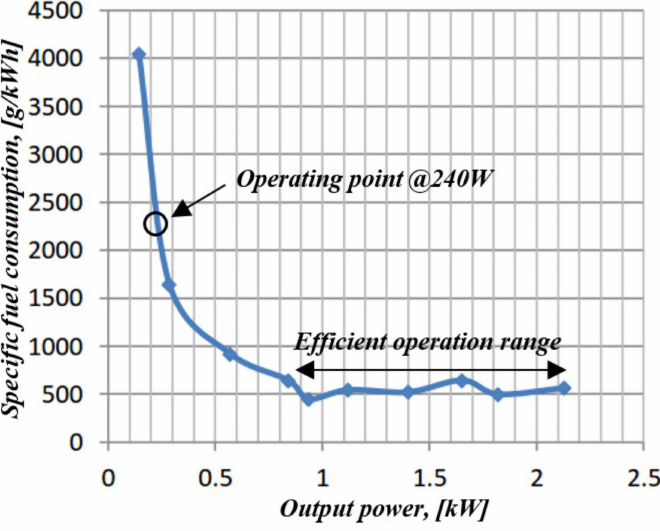
Figure 3. Measured APU specific fuel consumption versus output